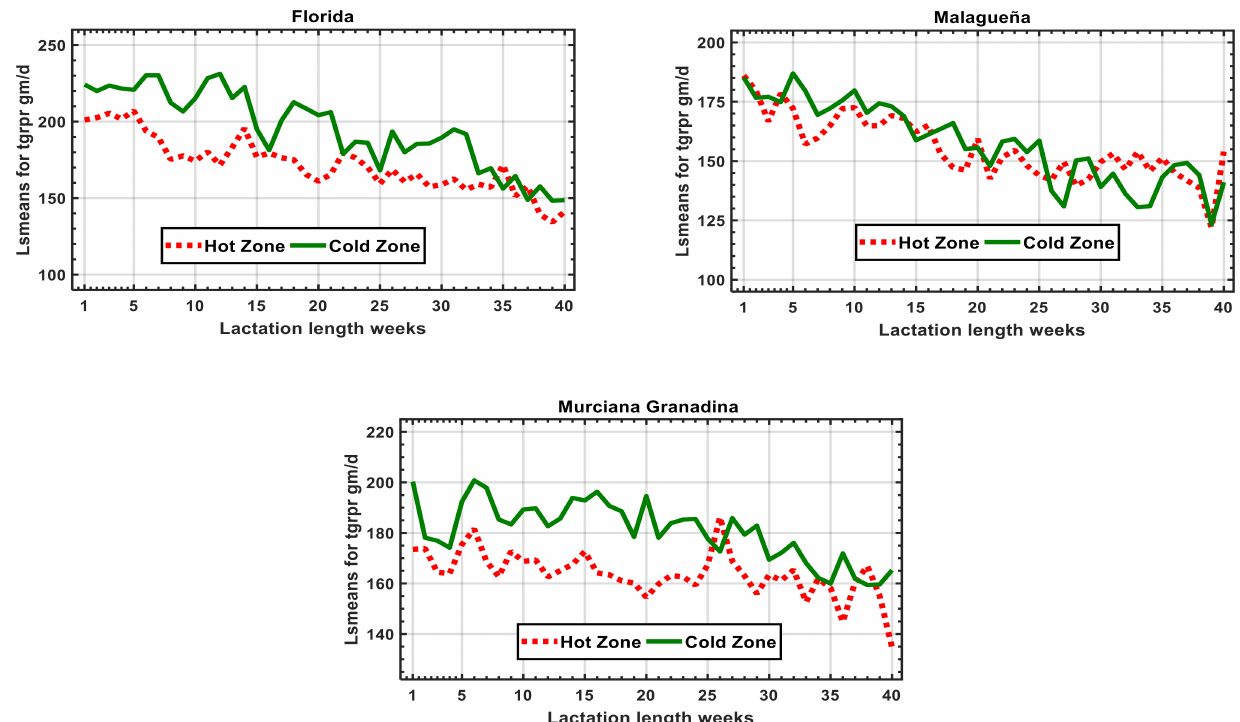
Figure 2. Least squares mean for total daily fat and protein yield (tgrpr) throughout lactation and two extreme climatic